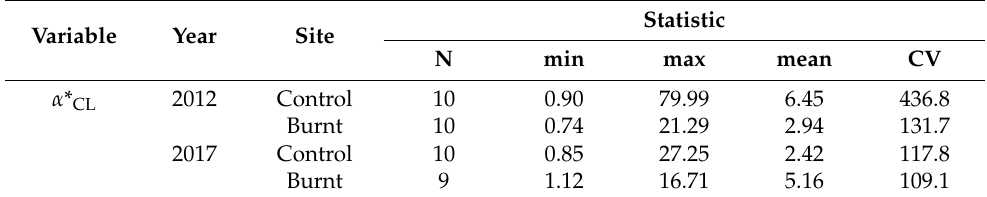
Table 2. Summary of the α * CL (m − 1 ) values obtained by the WU1 method for each sampling campaign and